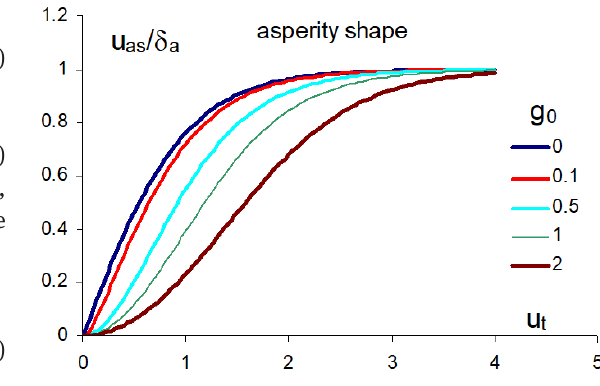
Figure 11: Shape of primary asperities depending on g